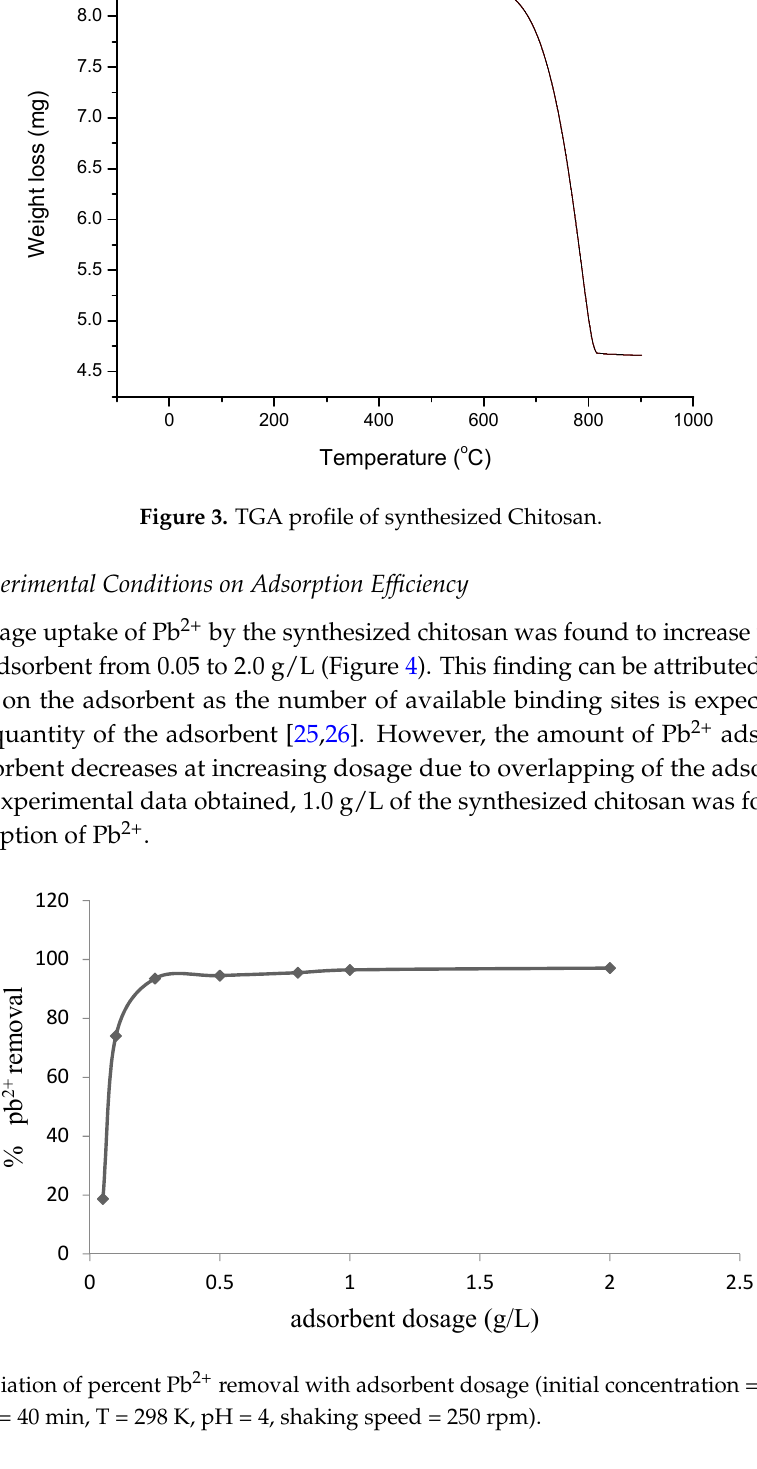
Figure 2. SEM micrograph of the adsorbent.